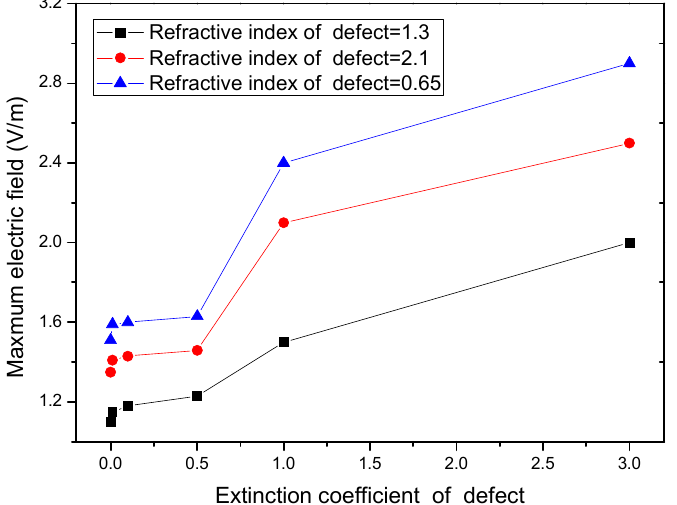
Figure 5. Light field intensification as a function of extinction coefficient of the defect. The previous results indicated that the defect in the film was equivalent to a micro ‐ lens [15,16], which focused on light lead to the local light field intensification. Here, we revisited the micro ‐ lens model for describing the focusing characteristics of defects. It is believed that the focusing effect of lens determined by the its focal length f , and that shorter focal lengths of the lens can lead to stronger focusing effects on the light. According to the formula: